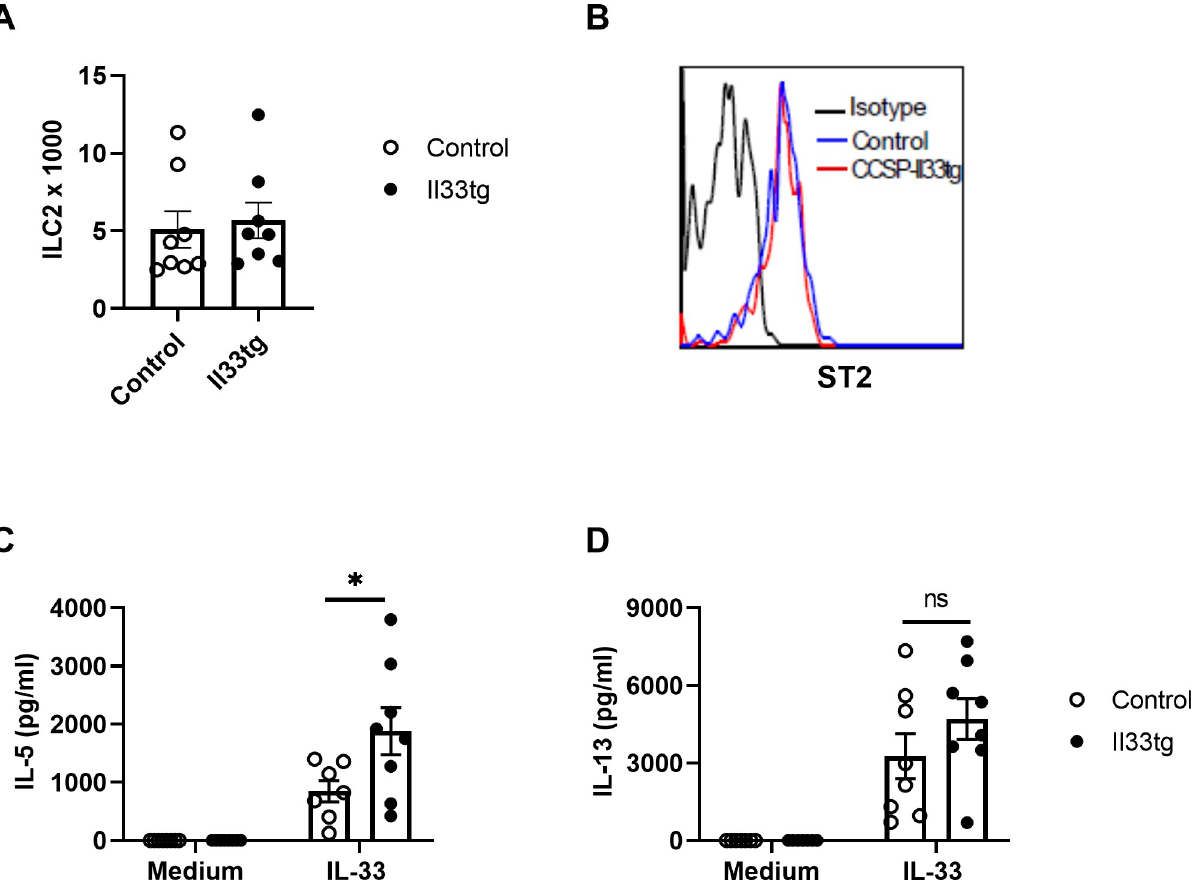
Fig 4. ILC2 function but not number was enhanced in neonatal-IL-33-experienced mice. Mice were provided with Dox water on postnatal days 6–13. After resting for 4–6 weeks, lung ILC2s were analyzed. (A) The number of lung ILC2s in neonatal-IL-33-experienced CCSP-Il33tg mice or control mice were quantified by flow cytometry (n = 8 mice per group). (B) ST2 expression by lung ILC2s was analyzed by flow cytometry. (C) (D) FACS sorted ILC2s were cultured with IL-33 for 4 days. IL-5 and IL-13 levels in culture supernatants were determined. Data are pooled from 3 independent experiments. Each dot represents one well in 96-well